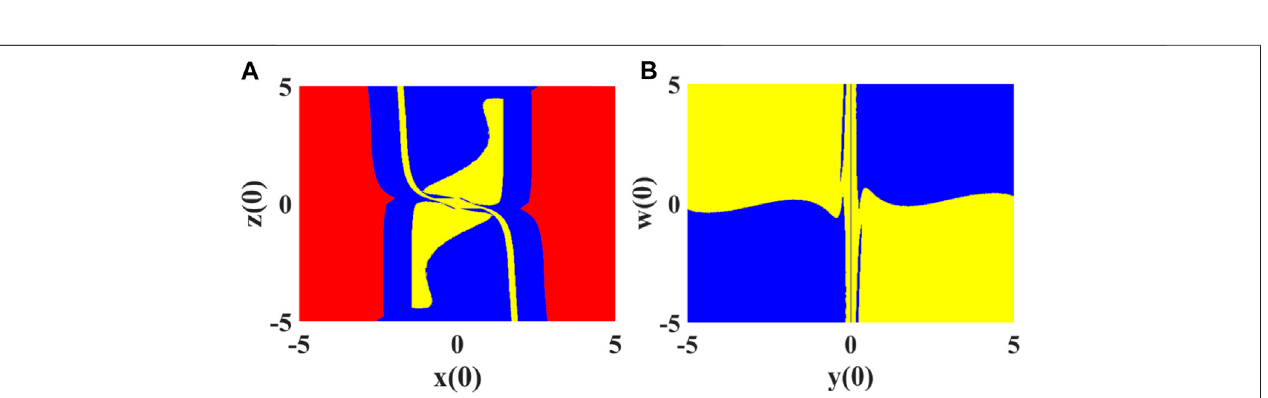
FIGURE 4 | The basin of attraction on the plane: (A) is the basin of attraction on the x ( 0 ) − z ( 0 ) plane; (B) is the basin of attraction on the y ( 0 ) − w ( 0 ) plane.